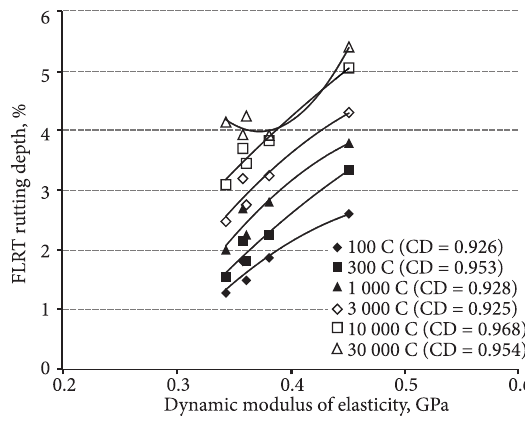
Fig. 4. Excellent relationships between dynamic modulus and FLRT rutting depth ( f = 10.0 Hz, T = +46.1 o C)